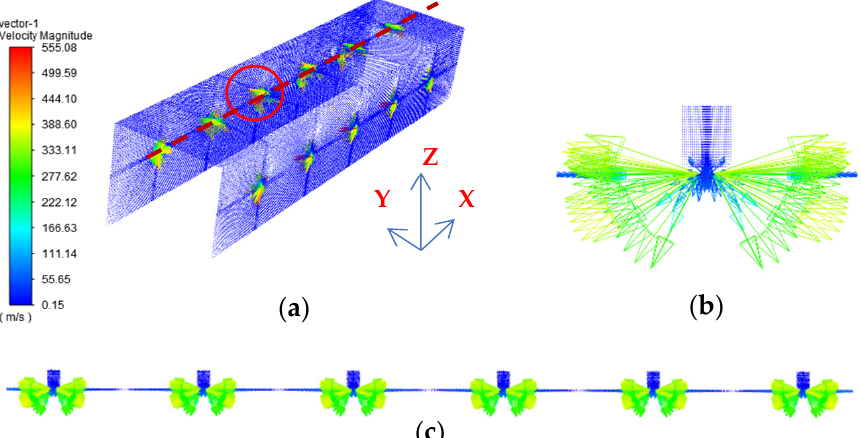
Figure 9. The velocity vector distribution of an air film in a balanced state (0.5 MPa). ( a ) Global view. ( b ) The position near a throttle hole. ( c ) The YOZ section of the air film (the highlighted line of the global view).